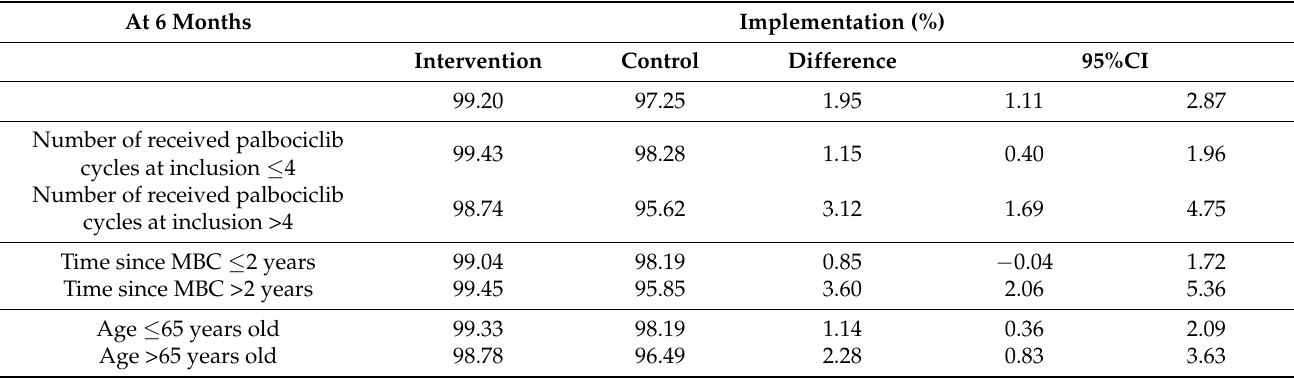
Table A1. Palbociclib implementation at 6 months in the different GEE models.